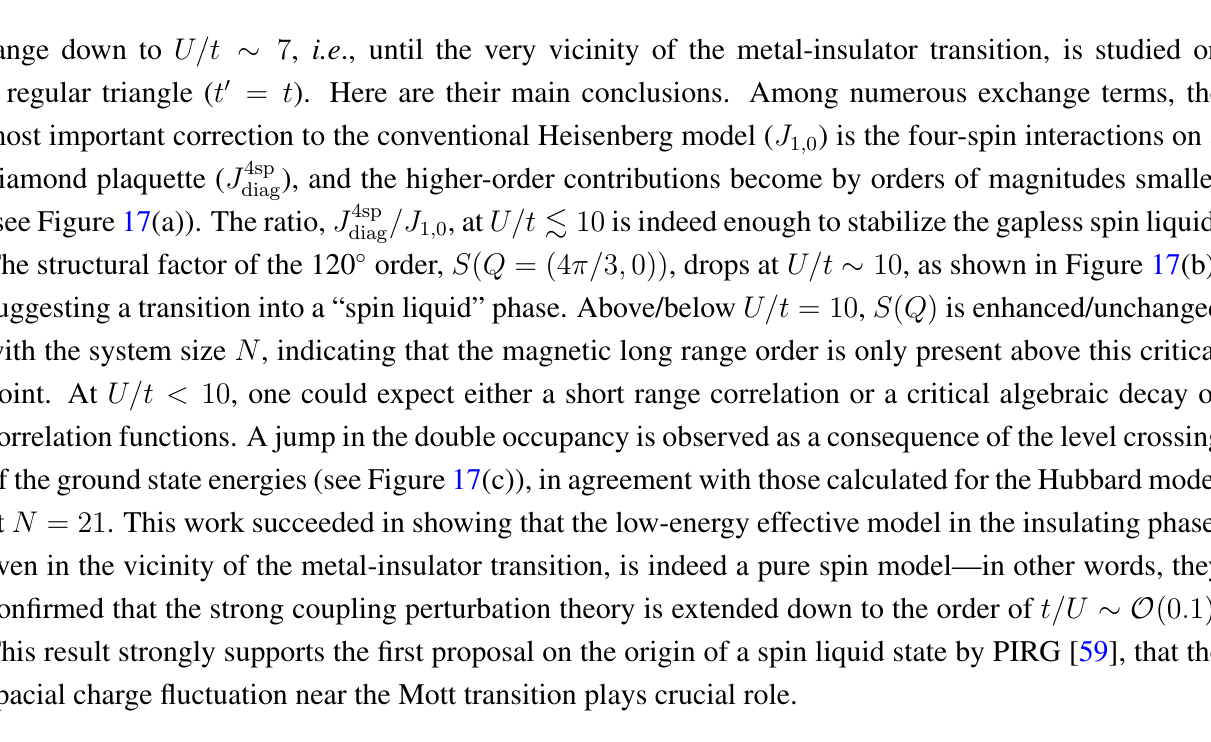
Figure 17. Numerical results by Yang et al . adapted with permission from [70], copyrighted by the American Physical Society. ( a ) Coupling constants of the multiple spin exchange processes by PCUT. Broken line at U/t ∼ 10 indicates a Mott transition; ( b ) Structural factor and ( c ) the double occupancy of the effective spin model by PCUT to compare with those of the original half-filled Hubbard model by the exact